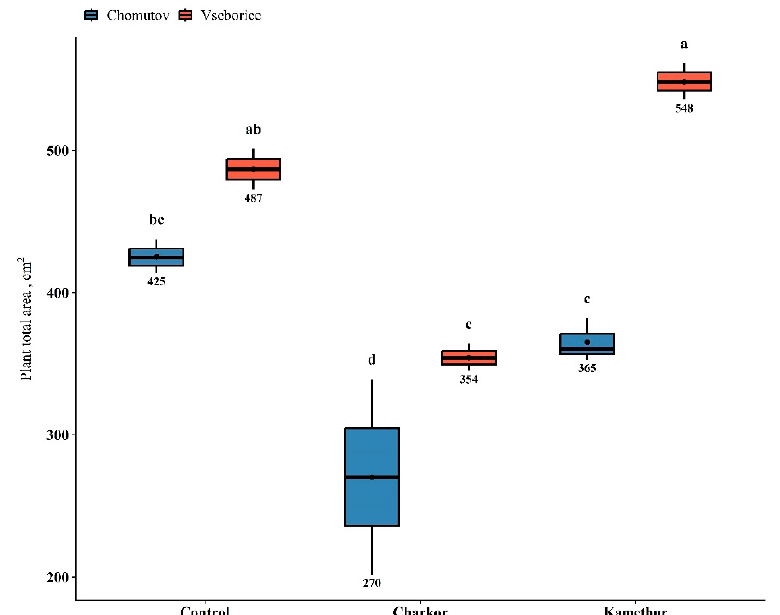
Figure 3. The calculated total area of M × g at harvest. Different letters indicate a significant difference between the values ( p < 0.05).